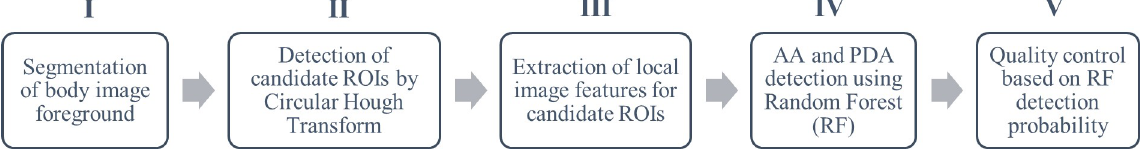
PLOS ONE | https://doi.org/10.1371/journal.pone.0212272 February 14,